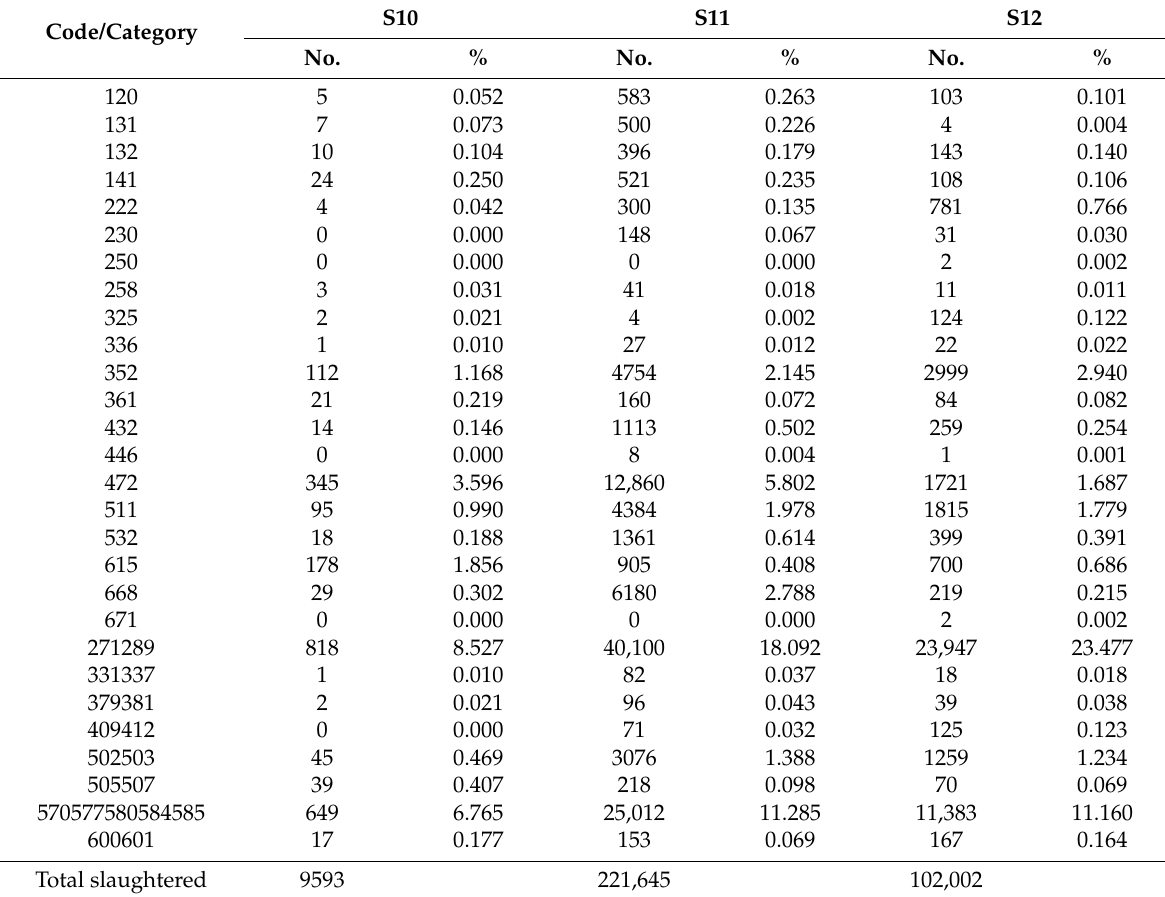
Table 2. Prevalence (number and %) of selected slaughter recording codes in sows slaughtered at the three largest sow slaughterhouses (S10–S12) in Denmark in